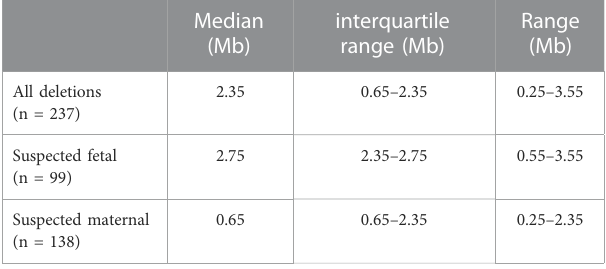
TABLE 1 Estimated 22q11.2 deletion sizes from